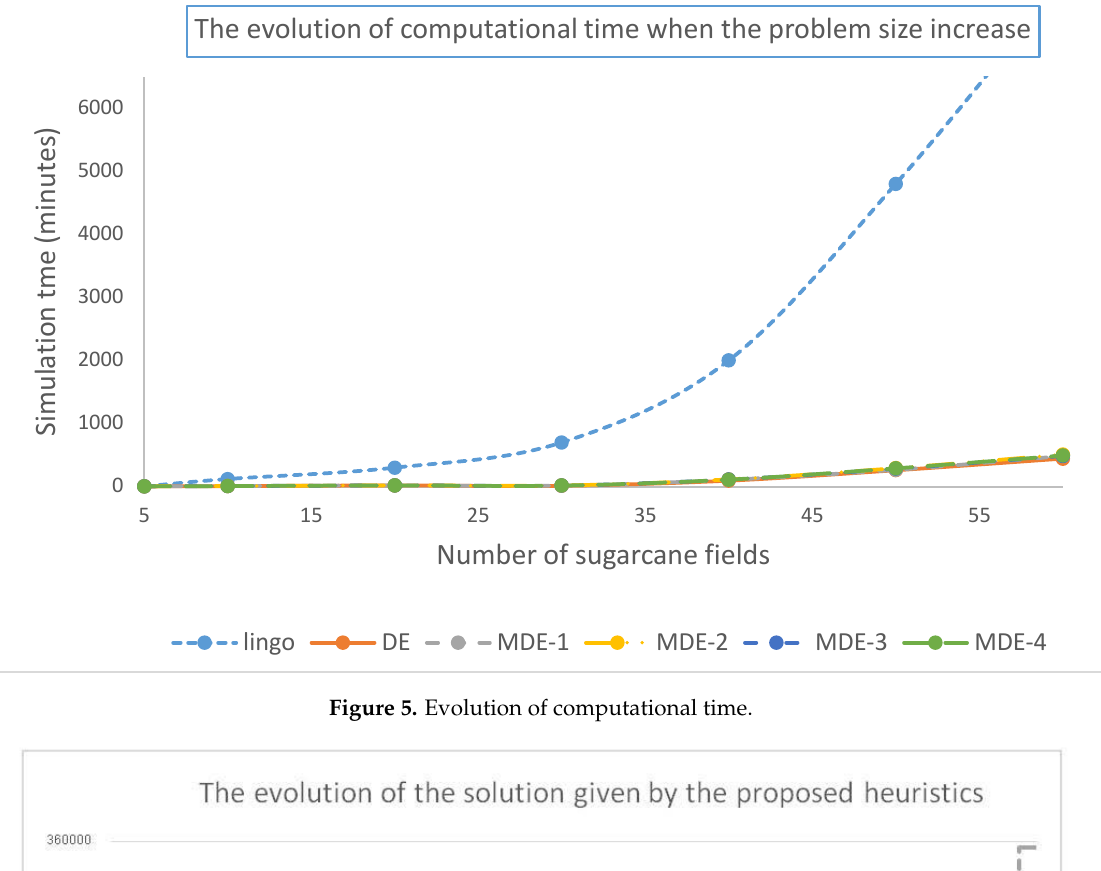
Figure 6. Evolution of the proposed heuristics.